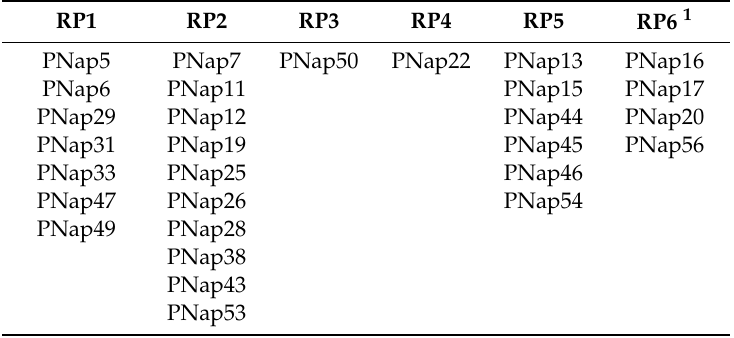
Figure 2. Restriction profile of phage DNA using PvuII . This gel documents 12 restricted phages in which three restriction profiles could be distinguished. Slot 1 and 14 molecular weight marker, slot 2, 3, 7, 8, 9 restriction profile 1 (RP1), slot 4, 5, 6, 10, 11, 13 restriction profile 2 (RP2), slot 12 restriction profile 3 (RP3). Table 2. Restriction profiles of 29 phages after digestion of phage DNA with PvuII.